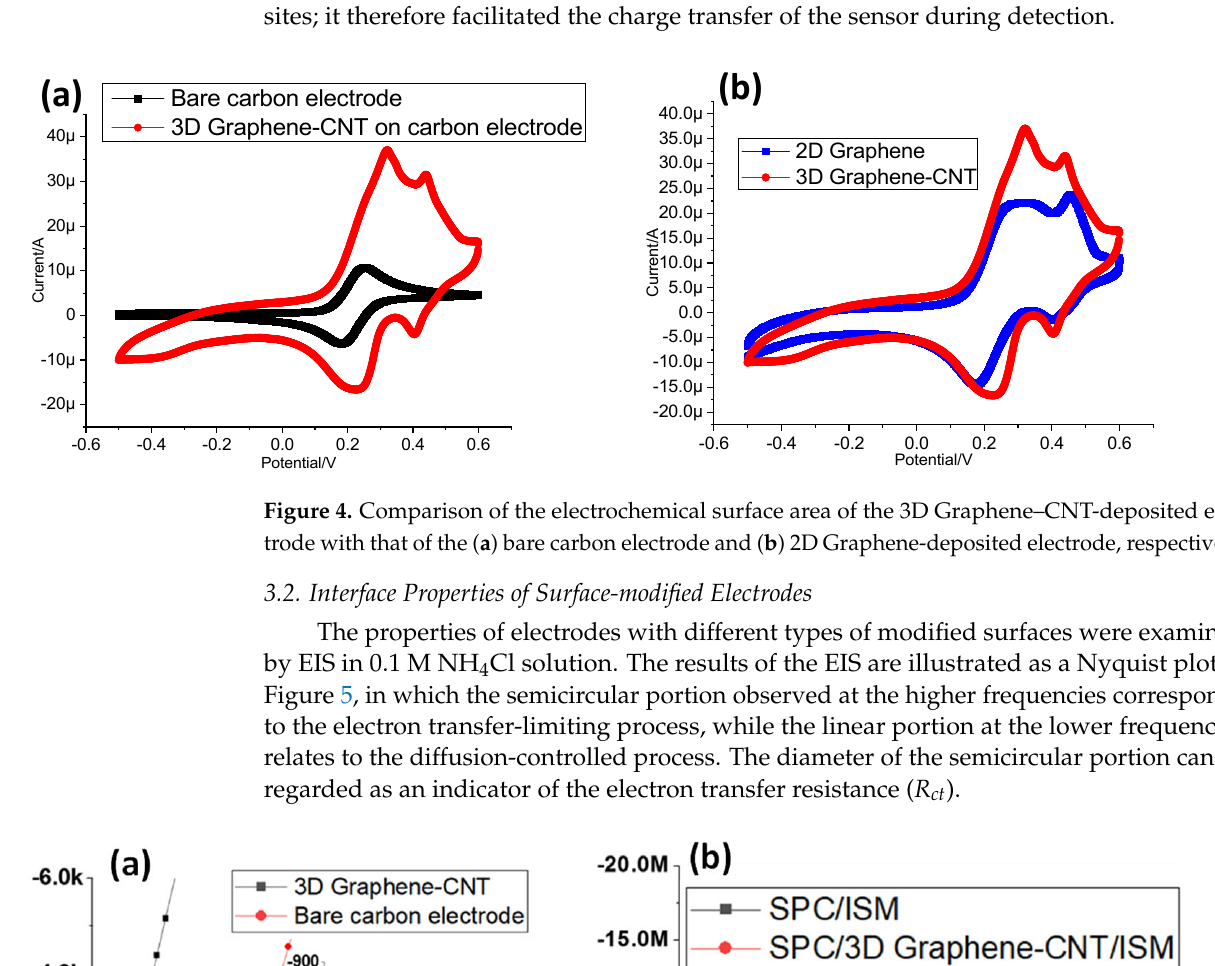
electrode surface that were able to significantly increase the number of accessible active sites; it therefore facilitated the charge transfer of the sensor during detection.